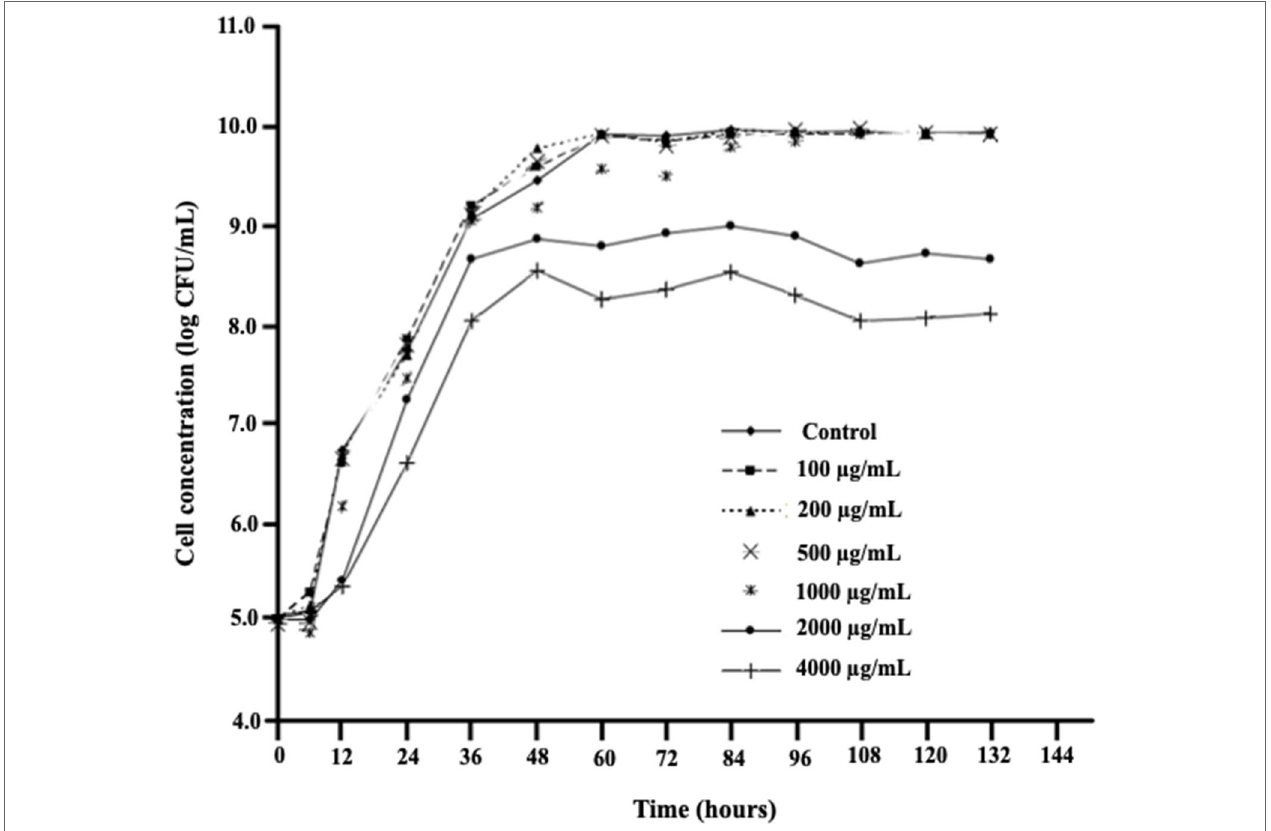
FIGURE 1 | The effect of increasing DON concentrations on growth patterns of D. mutans 17-2-E-8 in cornmeal broth cultures at 28°C and 200 rpm. The suppressive effect of DON was only noticed in concentrations that surpassed the 1,000 µg/ml indicating a very effective defense mechanism(s) of this bacterium against DON. The protected least significant difference [PLSD (0.05) ] of the presented results was